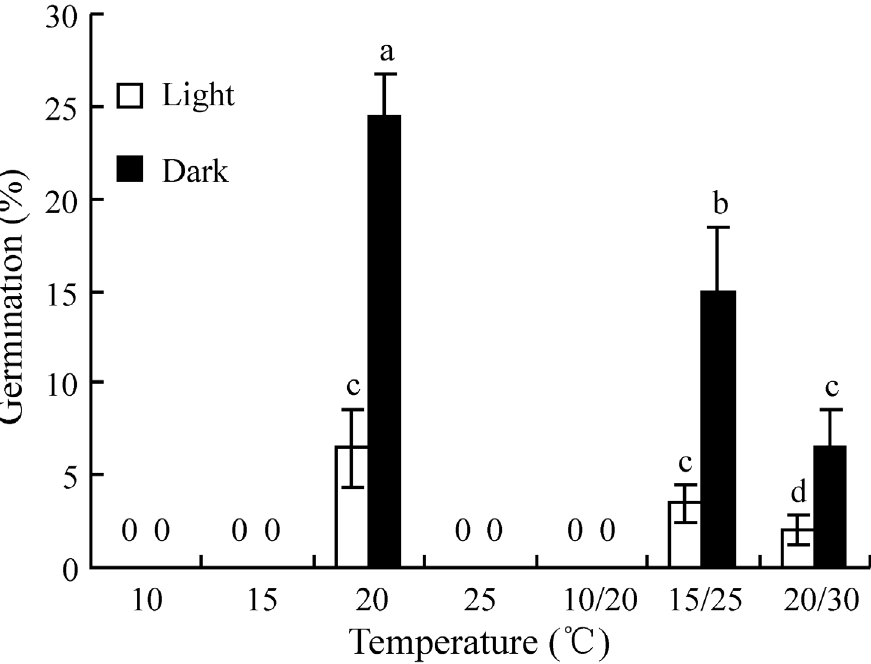
Figure 1. Effect of temperature on germination of fresh seeds of Stipabungeana in a 12 h/12 h photoperiod and in dark. Different letters indicate significant difference (P , 0.05) among all treatments (n=4).